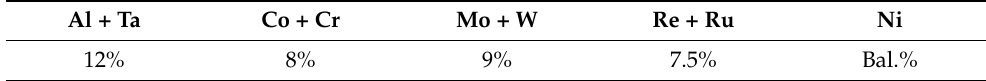
Table 1. Nominal composition of experimental alloy